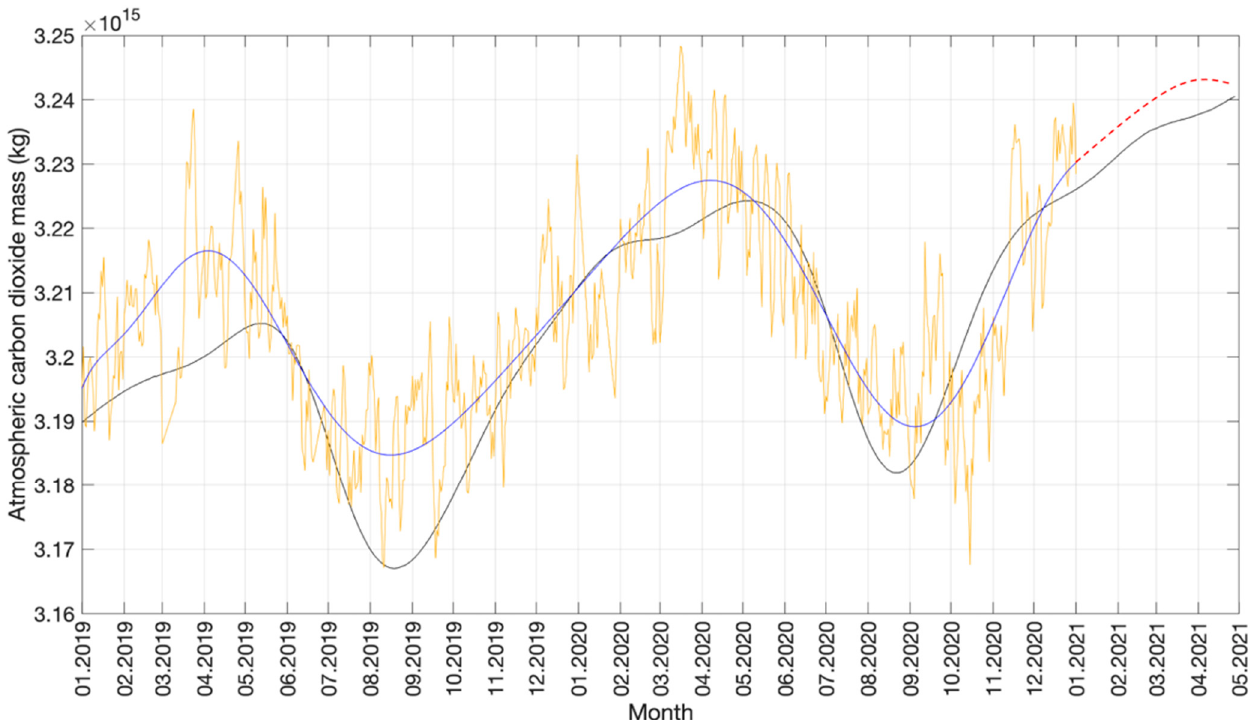
Figure 3. OCO2 global 4-day carbon dioxide mass estimation in the period 2019–2021. The orange is 4-day global atmospheric carbon dioxide mass estimation, the black curve is related to NOAA data, and the blue is the fitting curve. The red dashed line is the prediction of global carbon dioxide mass since the data was not available for OCO2.